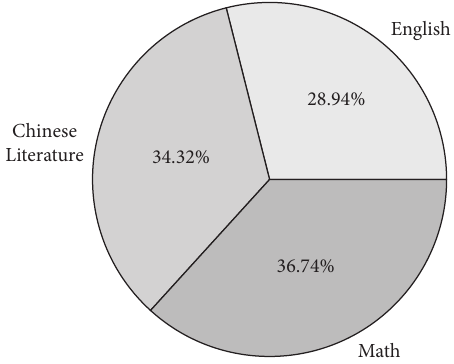
Figure 14: Mean concentration duration statistic report in aspects of different lectures.